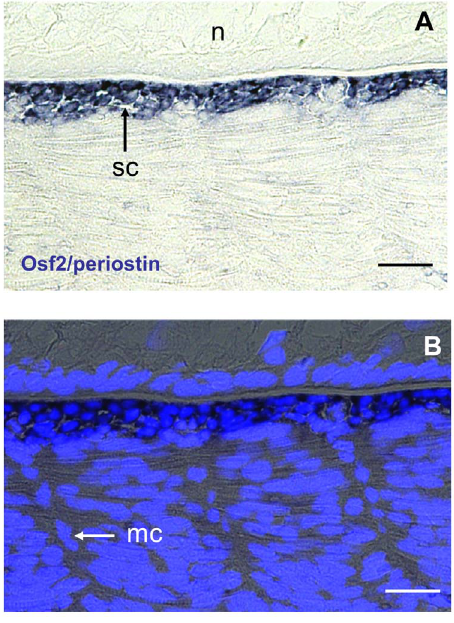
Figure 5. Skeletogenic cell specifically express osteoblast- specific factor2/periostin. Eyed-stage (17dpf) embryo, frontal section. ( A ) Labelling is restricted to sclerotome-derived skeletogenic cells (sc) surrounding the notochord. ( B ) Merged images with nuclei stained with Hoechst to visualise myoseptal cells (ms). Scale bars in A and B, 20 m m.